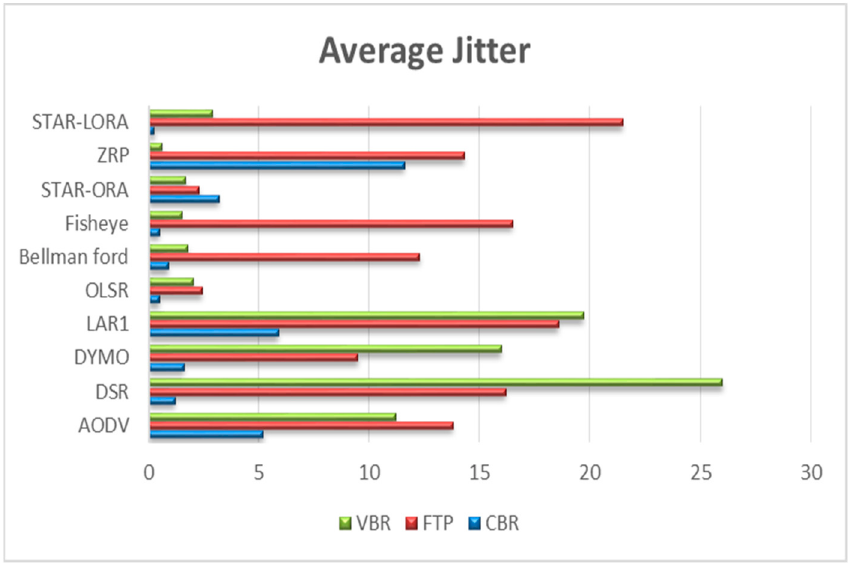
Figure 21. Average jitter of all routing protocols for 120 nodes.